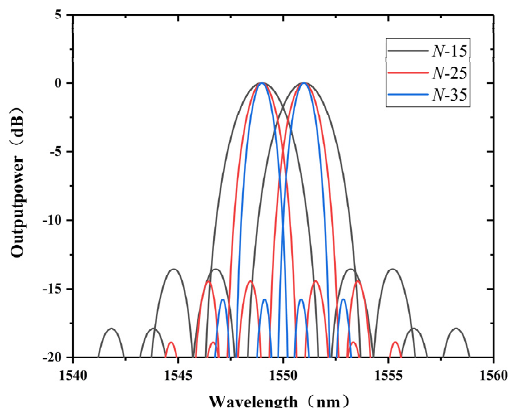
Figure 5. Transmission spectra of adjacent AWG channels under different arrayed waveguide quantities (N). Table 1. Parameters of designed SOI-based multi-channel AWG (8 × 8).